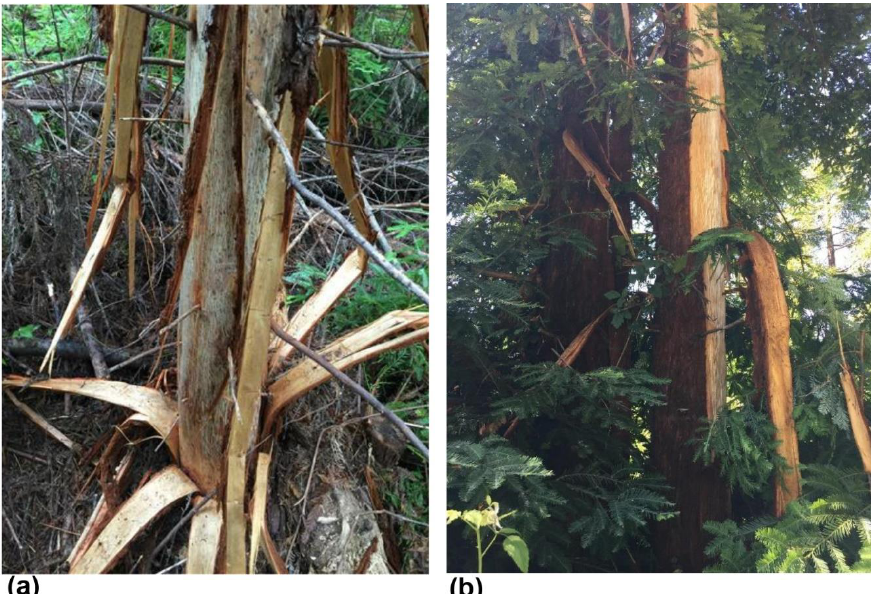
Figure 3. An example of fresh damage observed in the field: ( a ) A redwood tree completely girdled by a black bear; ( b ) A redwood tree with half of the bark removed from the trunk.